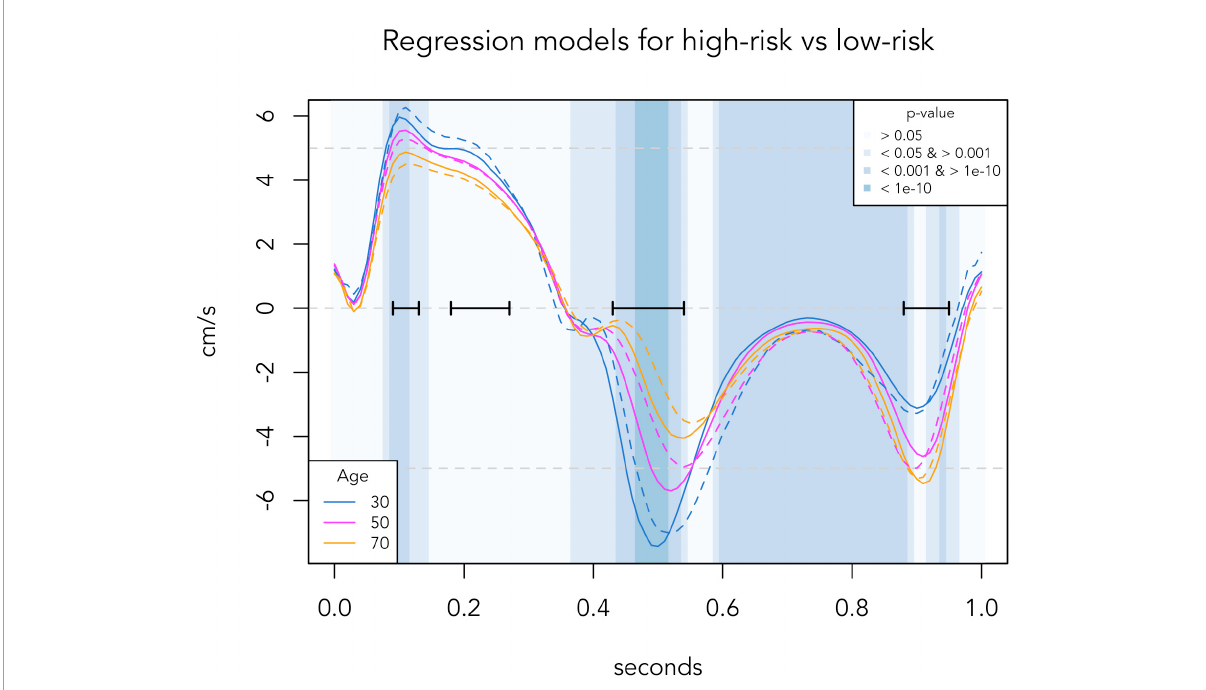
FIGURE3 Regression-based TDI curves of selected age groups, comparing the low-risk population (solid lines) with the corresponding age group in the high-risk population (dashed lines). Background colors indicate significance levels of the age-adjusted association between risk group and TDI values at each 0.01 s time-position. Black horizontal bars indicate the four phases identified in Figure 1 , where the TDI values differed most according to age. TDI values are averaged for septal and lateral mitral sites, presented for one standardized heart cycle of 1 s.